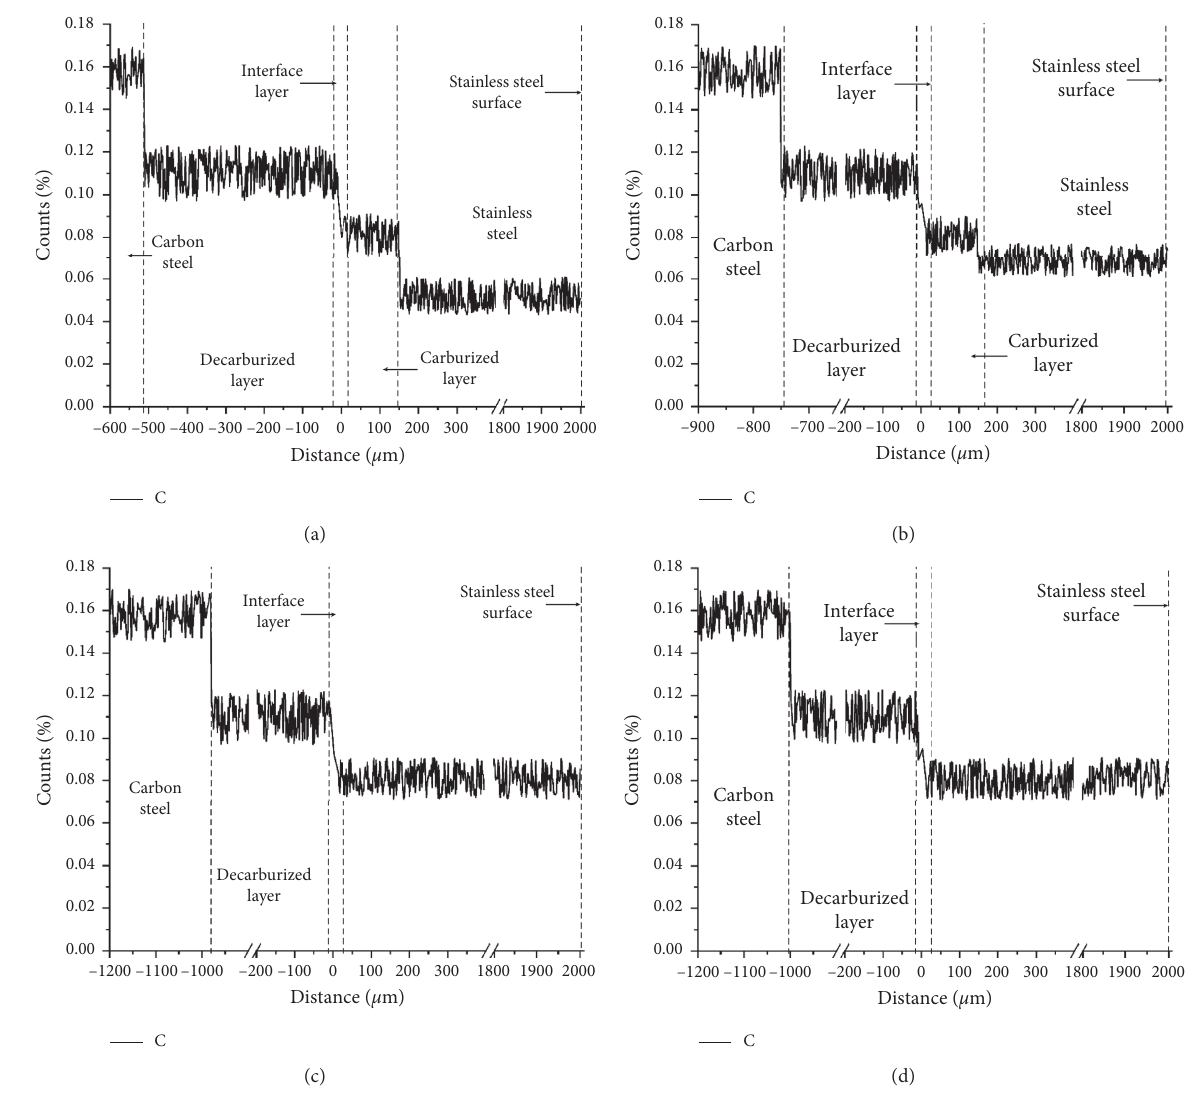
Figure 11: The element distribution of C in the thickness direction of the bimetal plate at 700 ° C with different annealing times: (a) 2h, (b) 4 h, (c) 6h, and (d) 8h.